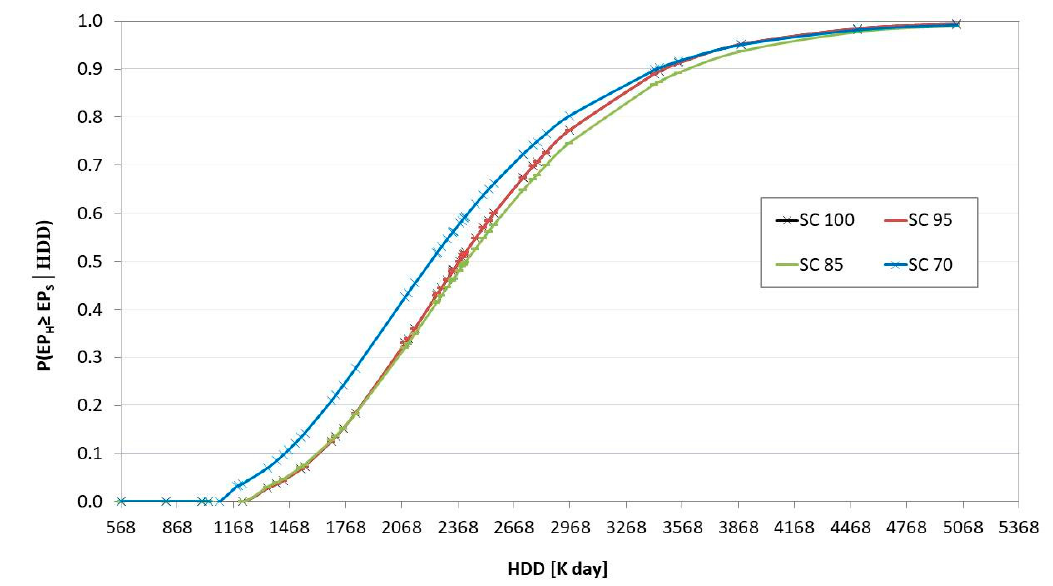
Figure 9. Energetic fragility curves—6-storey building.